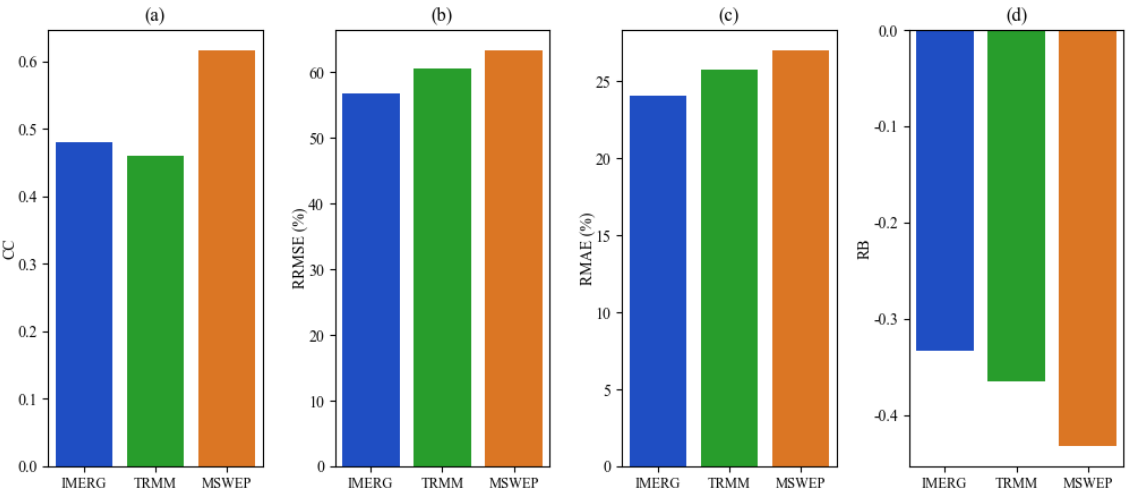
Figure 11. Continuous statistical metrics (( a ) CC , ( b ) RRMSE , ( c ) RMAE , and ( d ) RB ) of the three precipitation products for Max99.